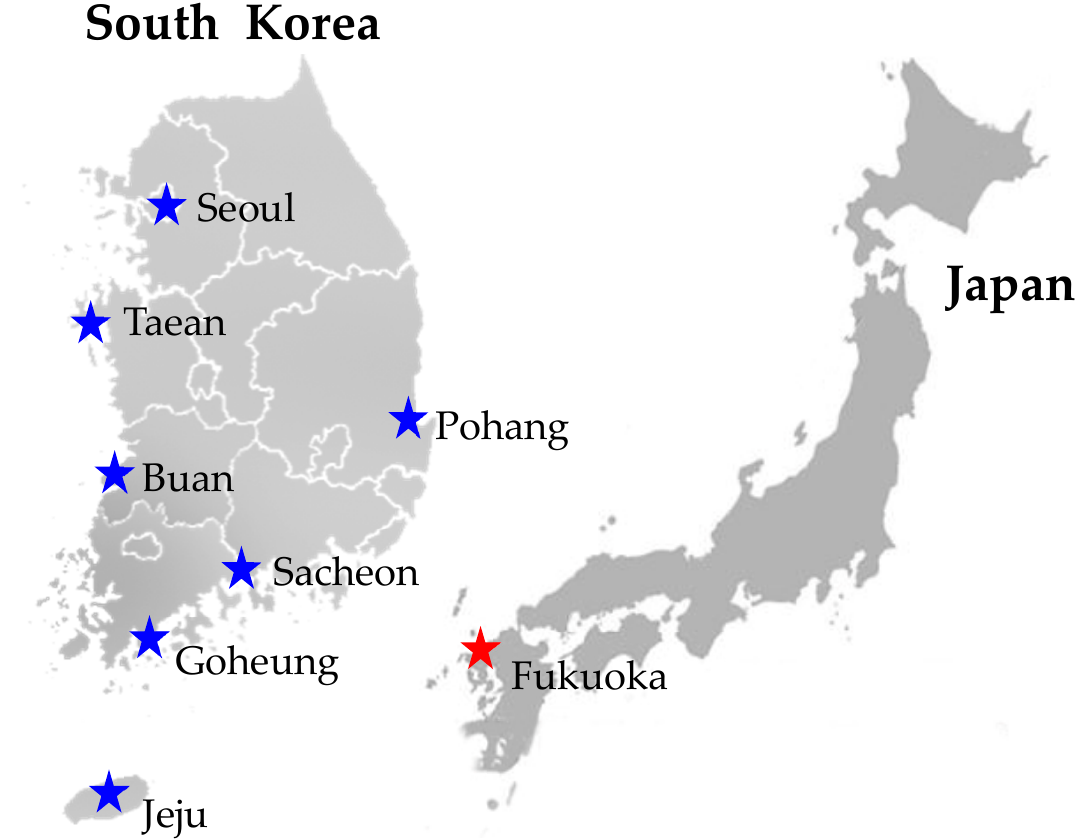
Figure 2. Sampling localities of Matsucoccus sp. in Korea and Japan.